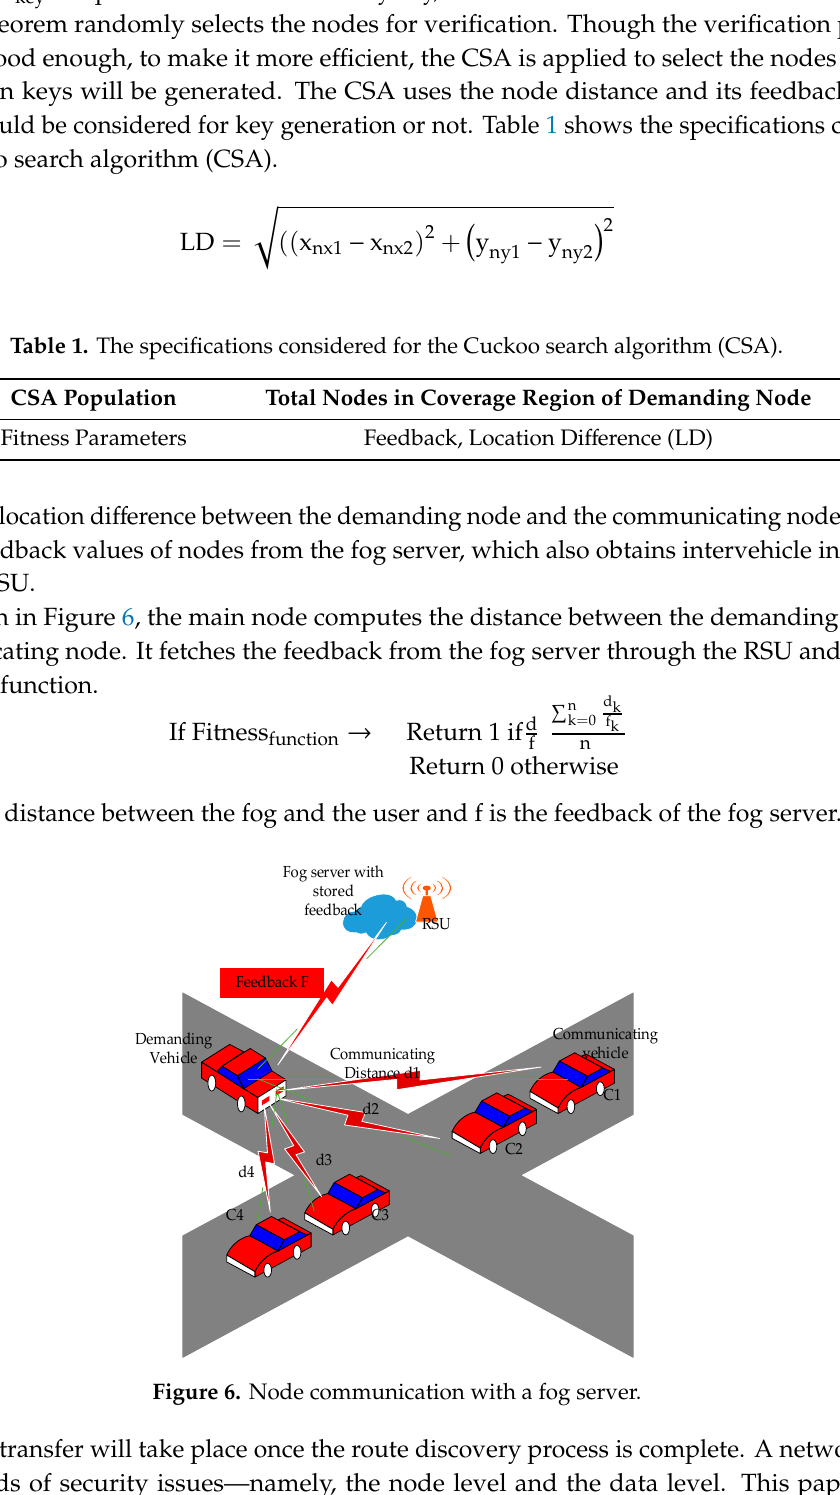
Table 1 . The specifications considered for the Cuckoo search algorithm ( CSA).